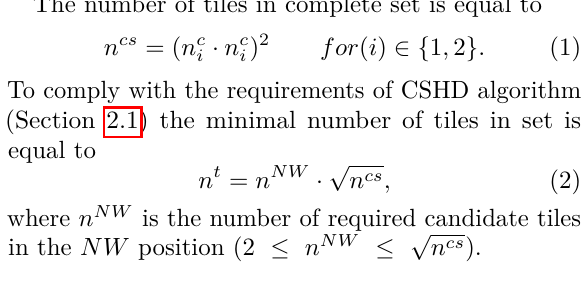
Figure 4. Wang tile set with n c combinations, i.e. complete set W16/2-2, b) mini- mal set W8/2-2 with particularly selected tiles for n NW =